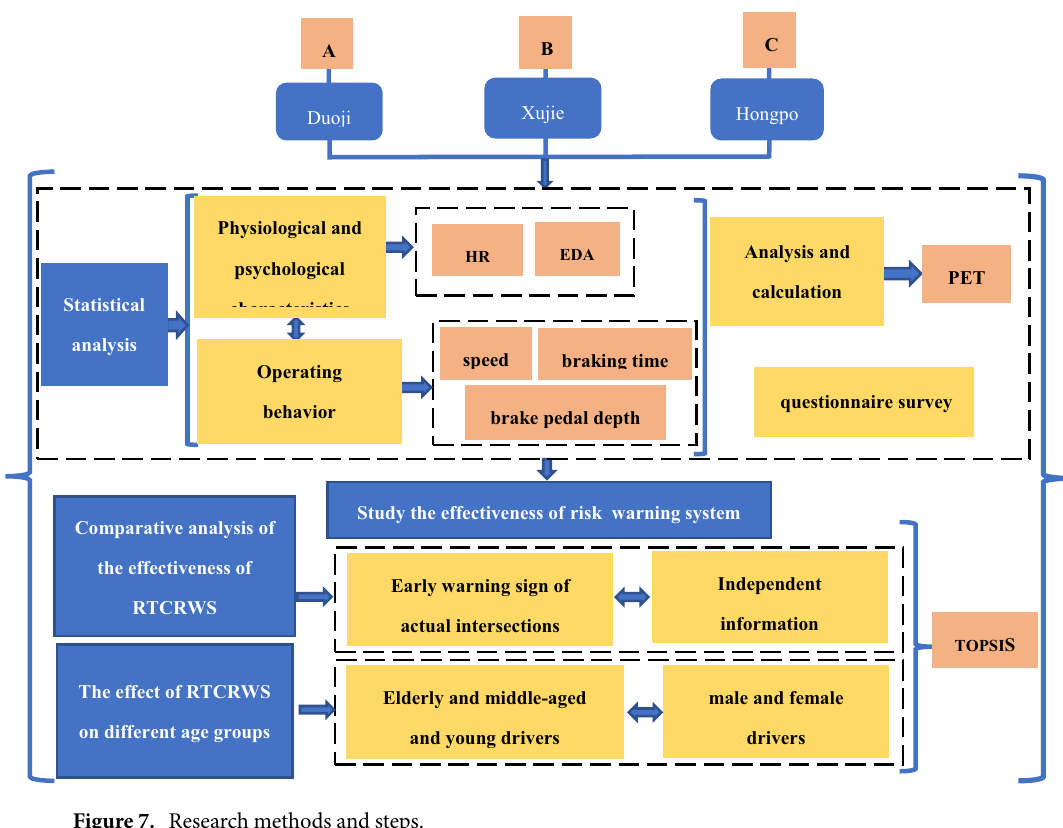
Figure 7. Research methods and